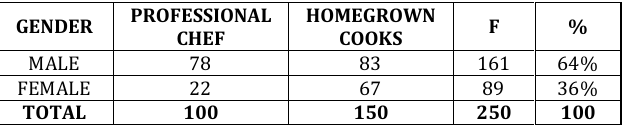
Profile of the Respondents based on Gender GENDER